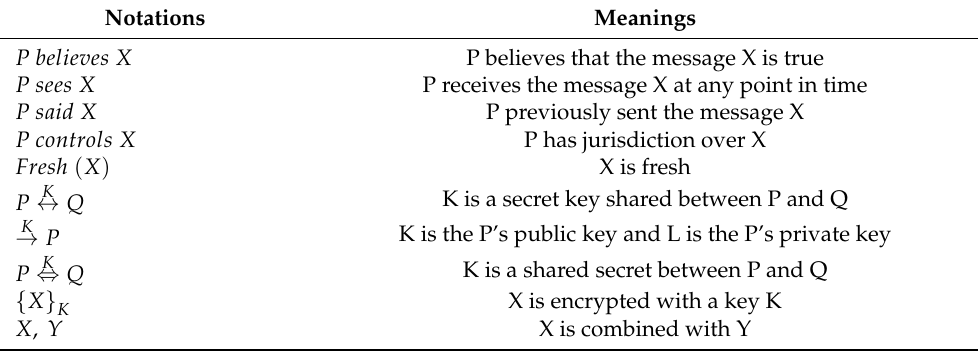
Table 2. BAN-Logic Notations.